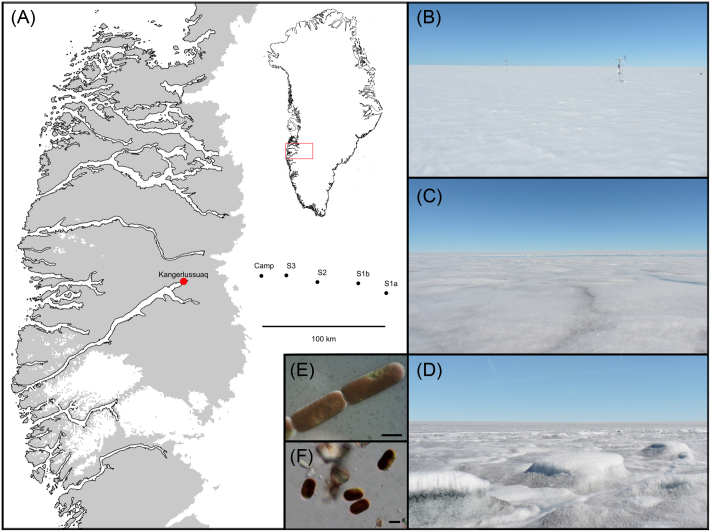
Sampling sites and camp location on the south-western Greenland ice sheet (A), with insert showing the relative position of the sampling region within Greenland. Transect 1 (sites S1a, S2 and S3) was performed on the 27th July 2016 (DOY = 209) and transect 2 (sites S1b, S2, S3) on the 5th August 2016 (DOY = 218). Images show the supraglacial surface environment of sites S1a (B), S2 (C) and S3 (D) during transect 1, illustrating the conspicuous increase in surface impurities apparent across transects toward the ice sheet margin. Ancylonema nordenskiöldii (E) and Mesotaenium berggrenii (F) were shown by this study to dominate surface ice across transects (scale bars = 10 μm in both cases).